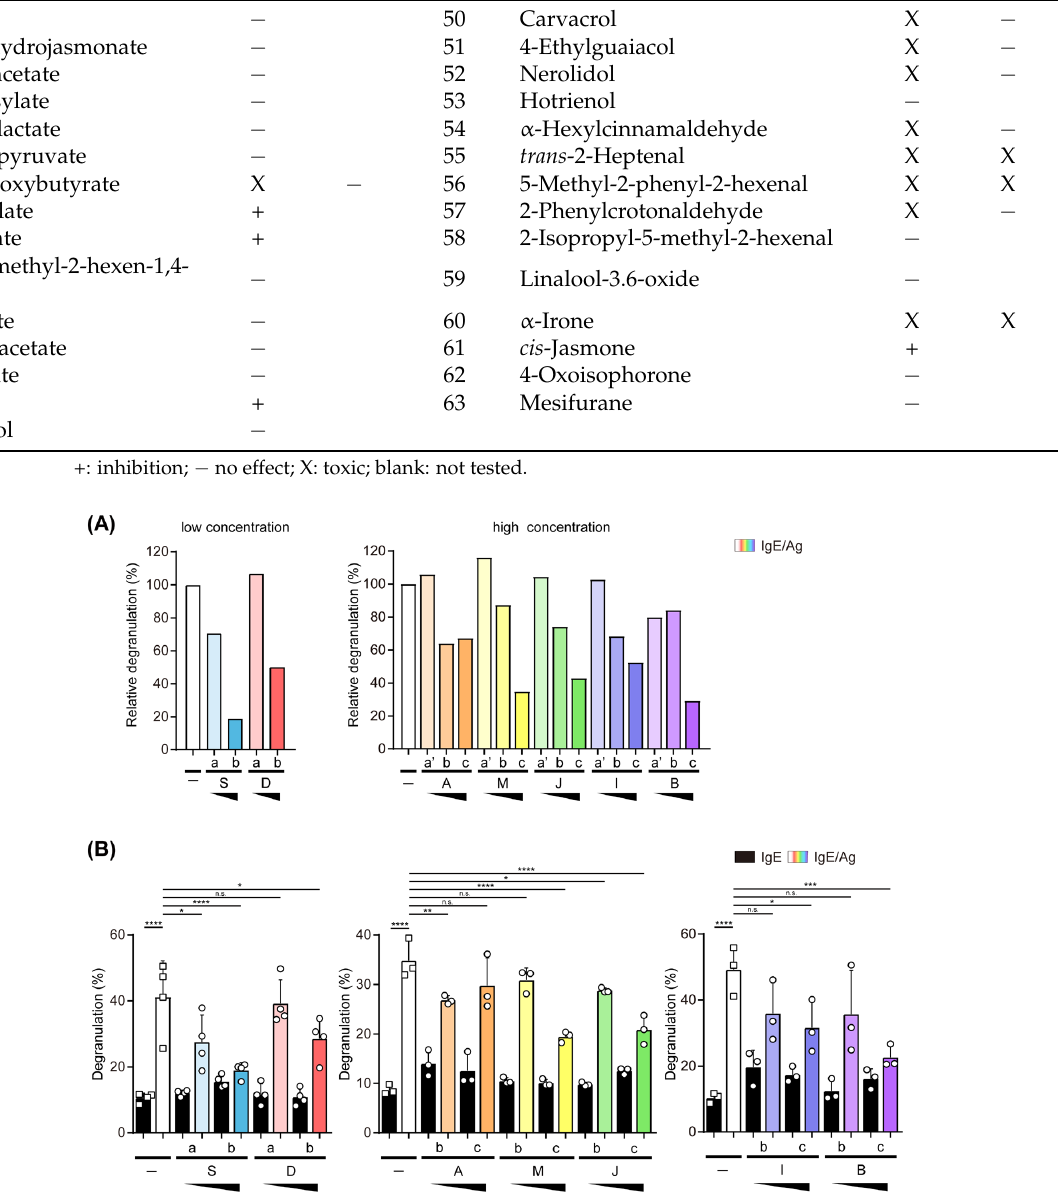
Figure 1. Suppression of the degranulation of MCs by candidate compounds selected from an aroma library. ( A ) Compounds passed through a screening using 0.001% v / v (left) and 0.01% v / v (right) (Table 1) were added to culture media of BMMCs at the indicated concentrations; left: a = 0.001%, b = 0.002%; right: a’ = 0.0004%, b = 0.002%, c = 0.01%; S, salicylaldehyde; D, diacetyl; A, ambrettolide; M, mintlactone; J, cis-jasmone; I, isoamyl salicylate; B, benzyl salicylate. Forty-eight hours after a preincubation with each compound, BMMCs were stimulated with anti-TNP IgE and TNP-BSA as described in the Materials and Methods Section. The relative degranulation to that of control BMMCs without compounds (=100%) is shown. ( B ) Degranulation assay data obtained from 3 independent experiments, in which different independently prepared lots of BMMCs were used; left: a = 0.001%, b = 0.002%; center and right: b = 0.002%, c = 0.01%; S, salicylaldehyde; D, diacetyl; A, ambrettolide; M, mintlactone; J, cis-jasmone; I, isoamyl salicylate; B, benzyl salicylate. Dunnett’s multiple comparison test was used for statistical analyses. *, p < 0.05; **, p < 0.01; ***, p < 0.001; ****, p < 0.0001; n.s., not